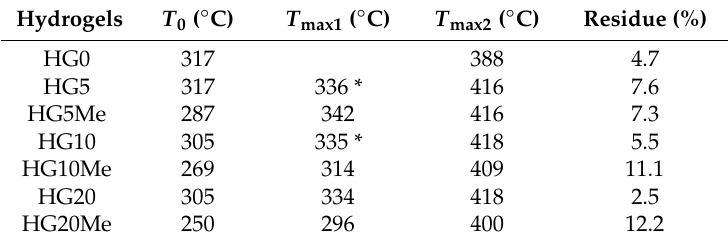
Table 2. The characteristic parameters of hydrogels’ thermal degradation. Figure 3. Thermogravimetric analysis (TGA) and dTG curves of ( A ) unmodified and ( B ) methylated hydrogels.